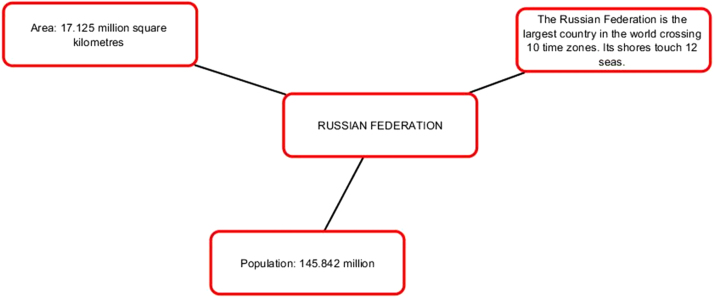
Infographics “Russian Federation” [1].